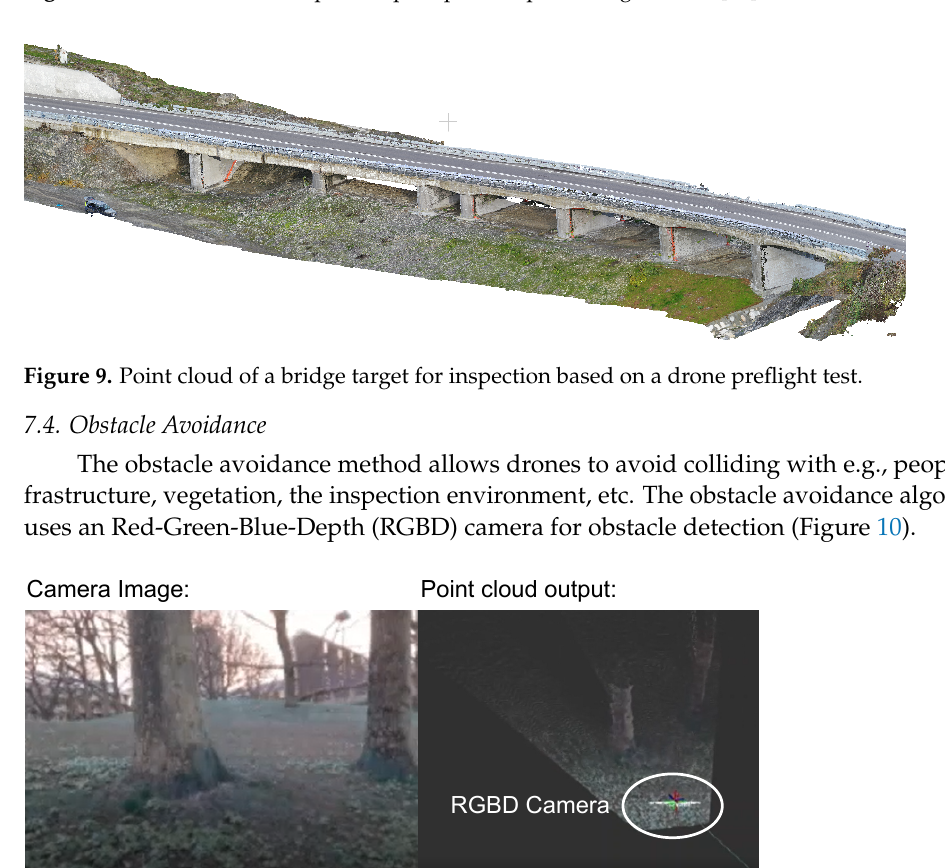
Figure 10. Example of the use of RGBD camera for obstacle detection. The camera senses the trees observed with the front camera (to the left ) and outputs point cloud data relative to the camera frame (to the right